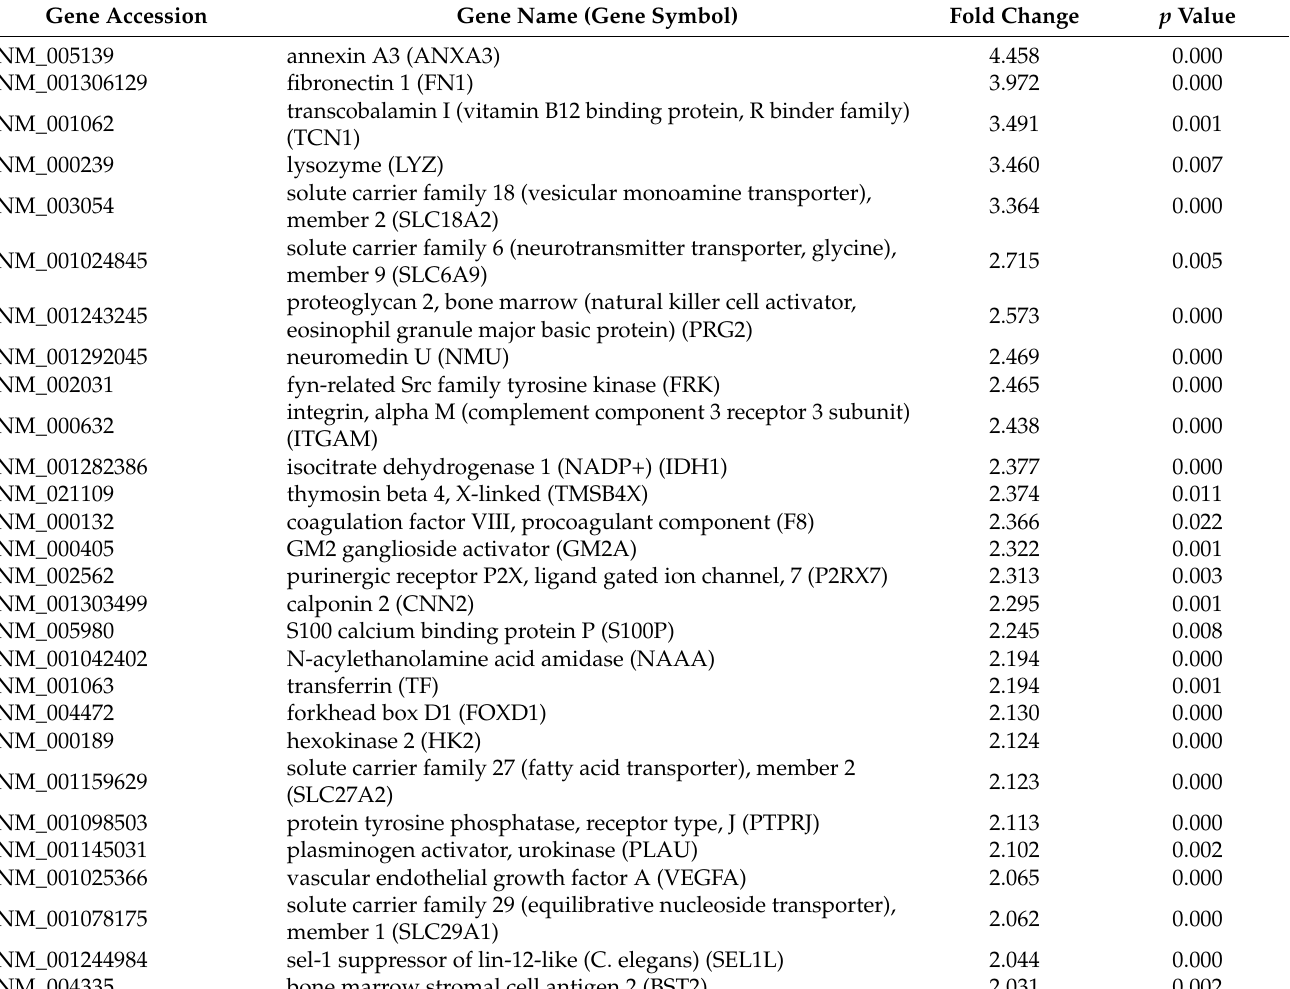
Table 1. Upregulated secretory genes in response to K562 differentiation into